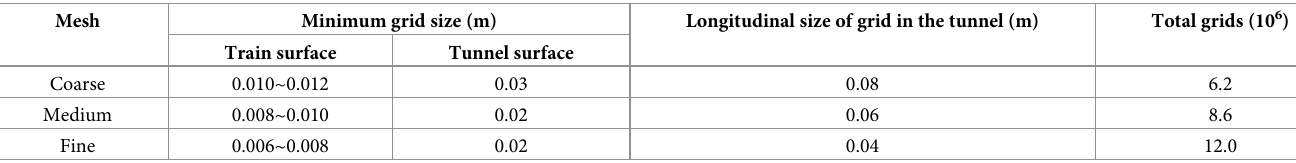
Table 1. Parameter values for verifying mesh independence.